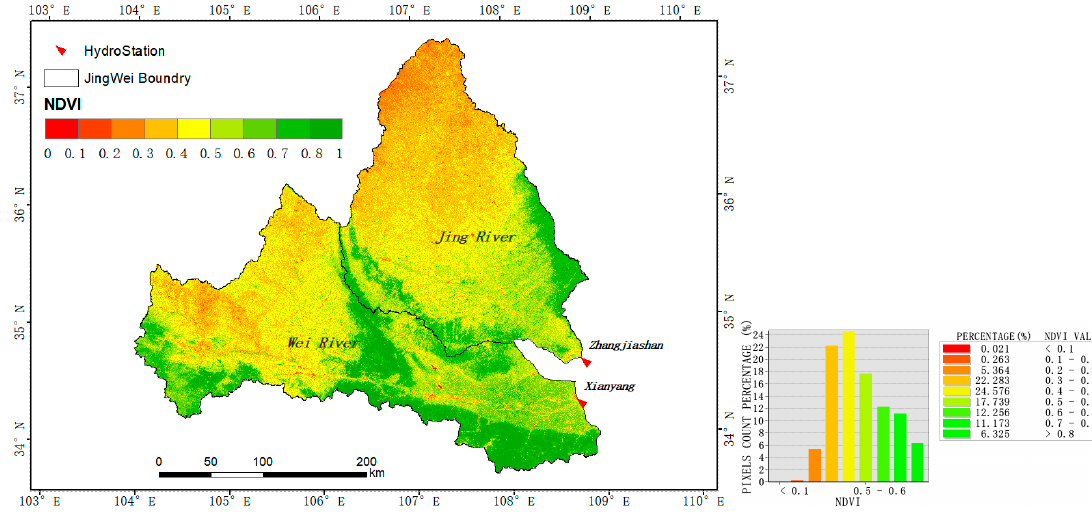
Figure 5. Spatial distribution of NDVI (mean value in growth season) from 1987 to 2018 in Wei and Jing River Basin.